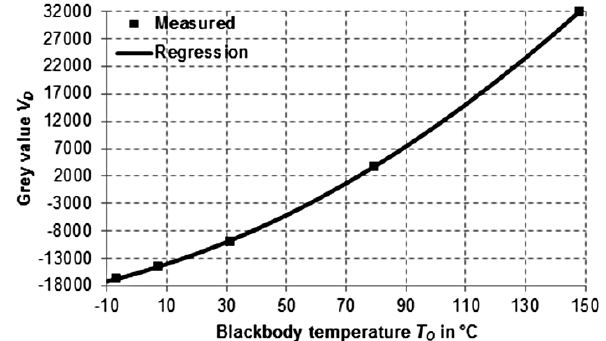
Figure 14. Object temperature ϑ S vs. signal voltage V D char- acteristic. Regression according to Eq. (50) where B = 1514 . 3K; F = 0 . 920; R = 1967454; and Off =− 23392.